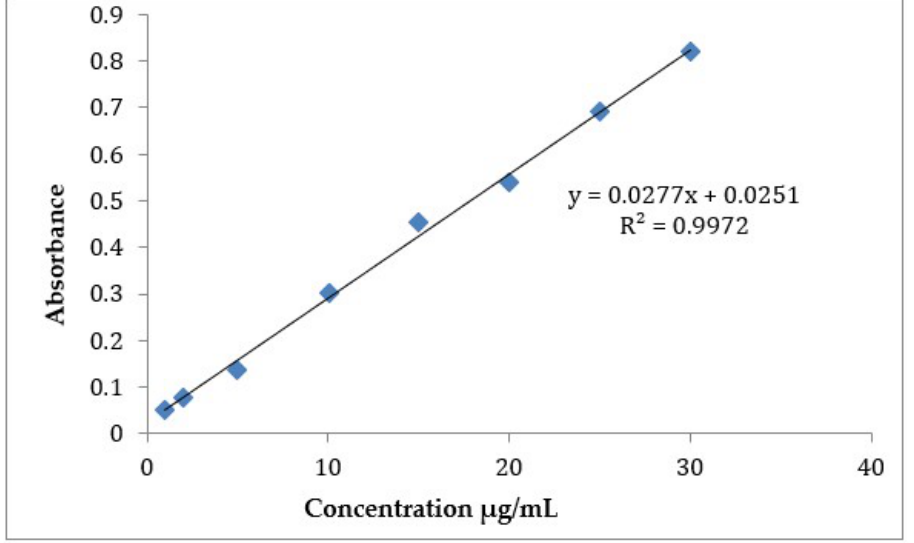
Figure 1. Calibration curve of CLZ determination using UV/VIS spectrophotometry in distilled wa- ter.